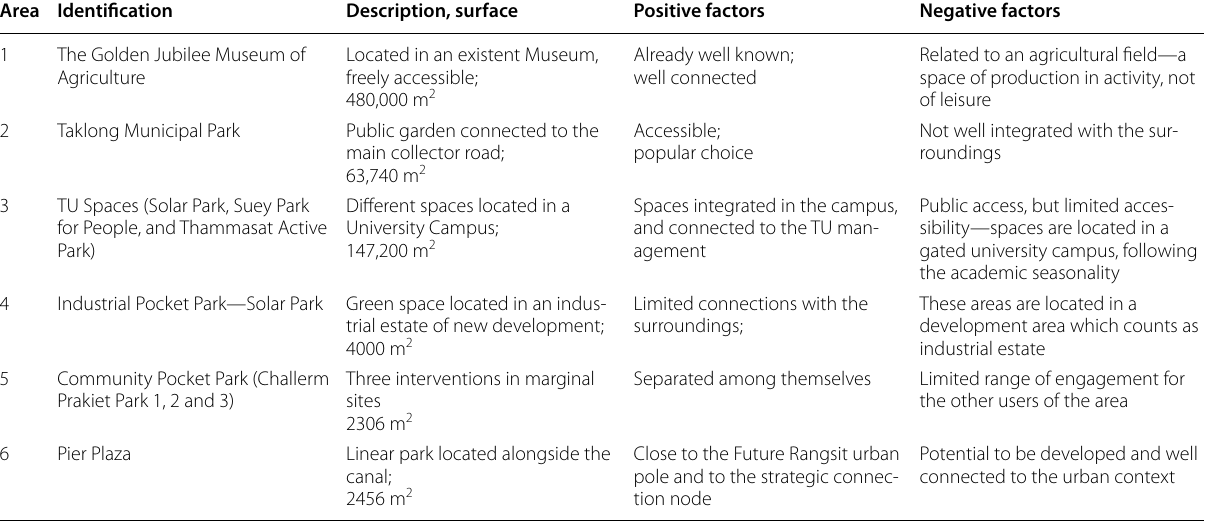
Table 2 Considerations of the existing parks. Sources: Researcher Team, 2022 Area